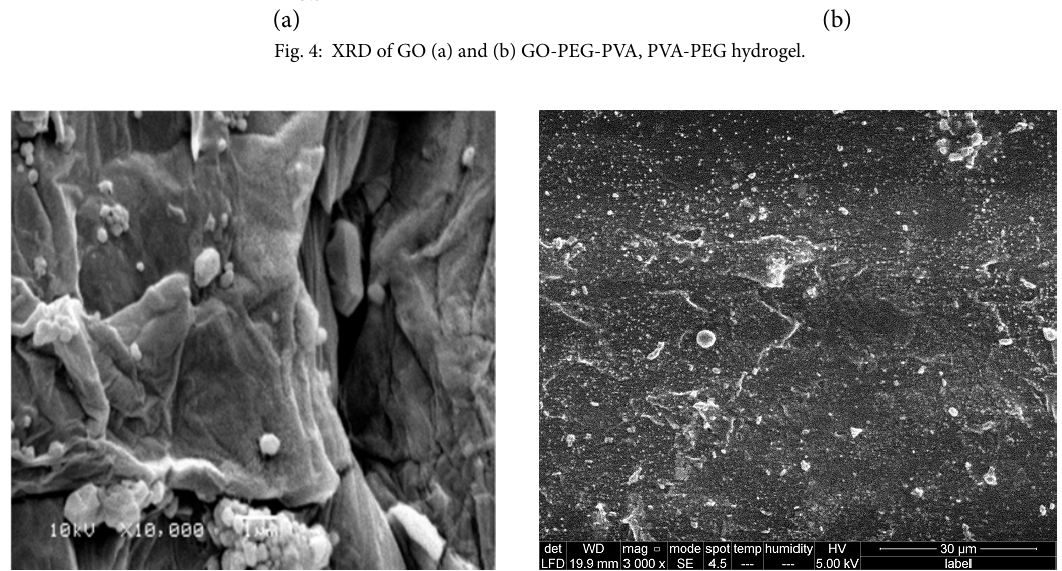
Fig. 5: (a) SEM micrograph of graphene oxide, (b) GO-PEG-PVA composite